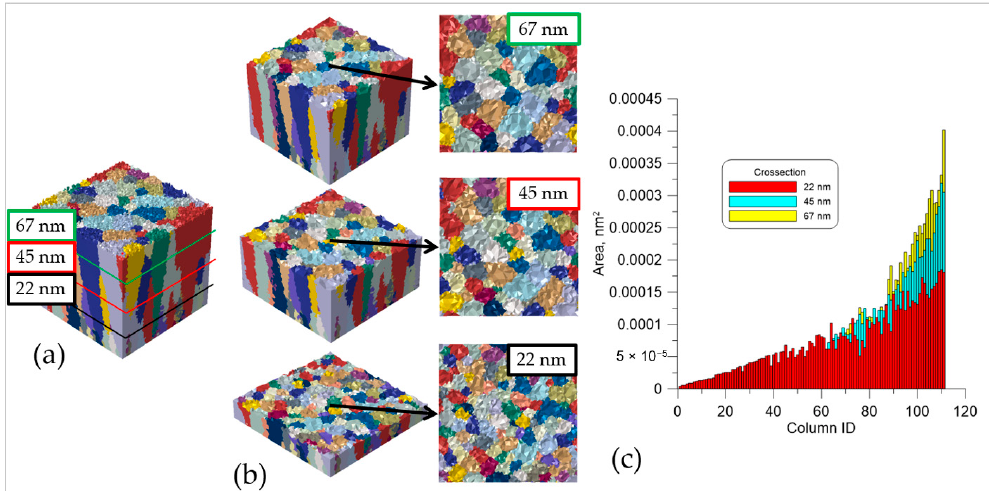
Figure 6. ( a ) position of the cross-section in the final DMR sample, ( b ) illustration of columns at particular cross-sections, and ( c ) diagram representing areas of subsequent columns at particular cross-sections.